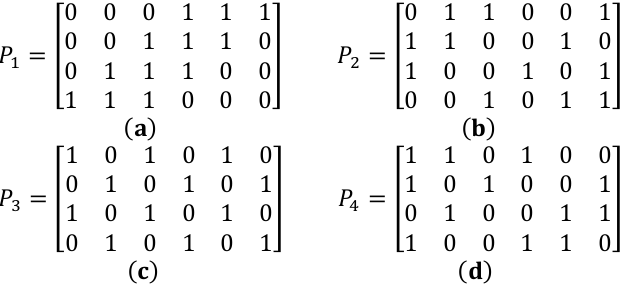
Figure 1. A sharing matrix example of (3, 4) thresholds with 4 × 6 matrix size.